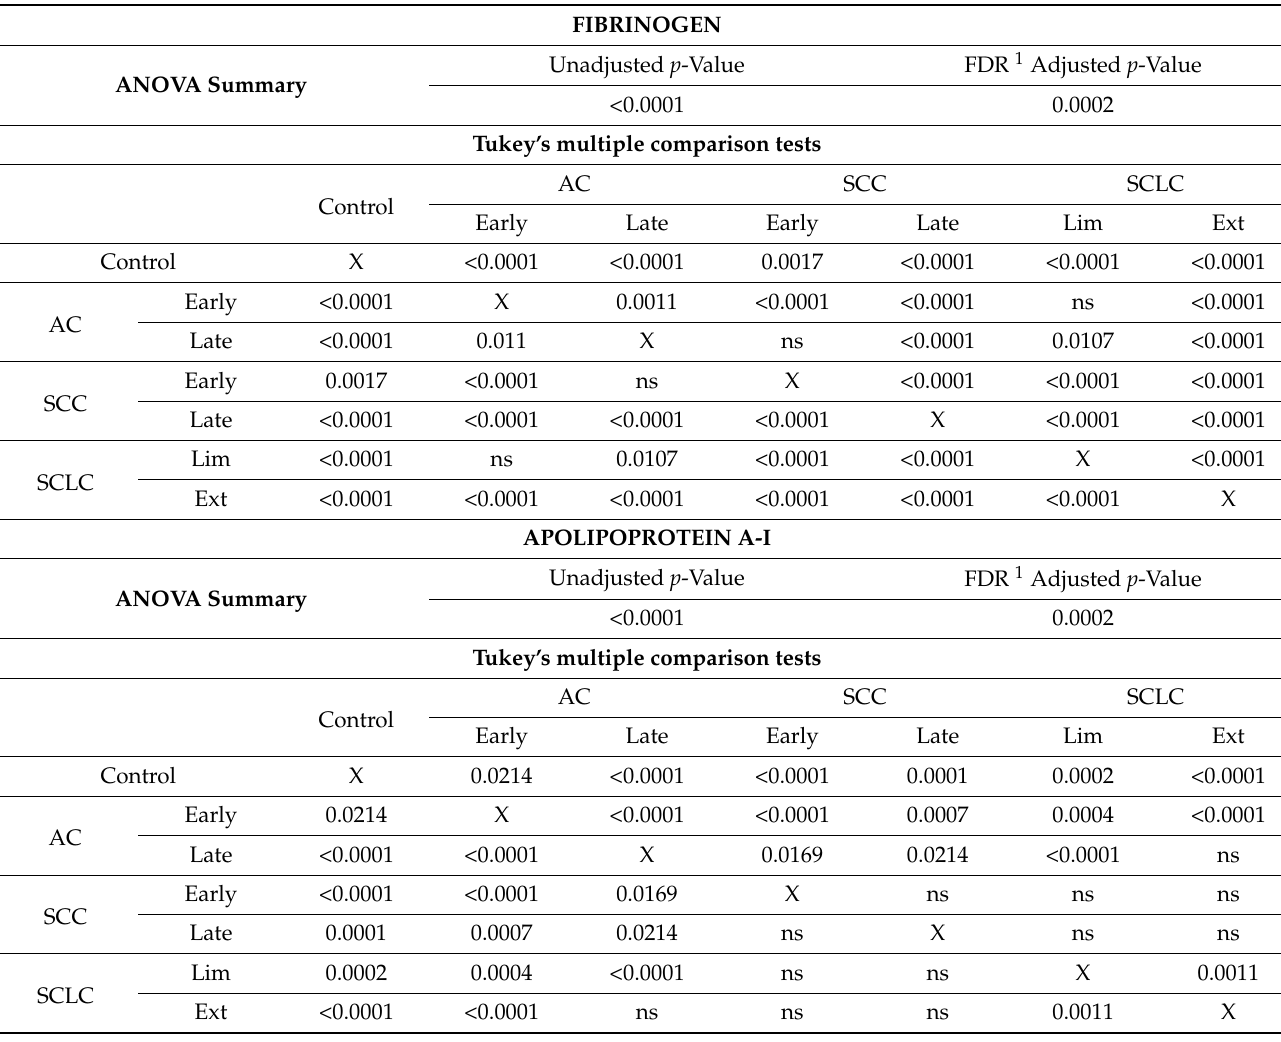
Table 3. Summary of the p -values of selected plasma proteins for repeated measures ANOVA and Tukey’s multiple comparisons. Tests evaluate the differences between clinical groups using mass spectrometry glycosylation data of peptides grouped according to protein